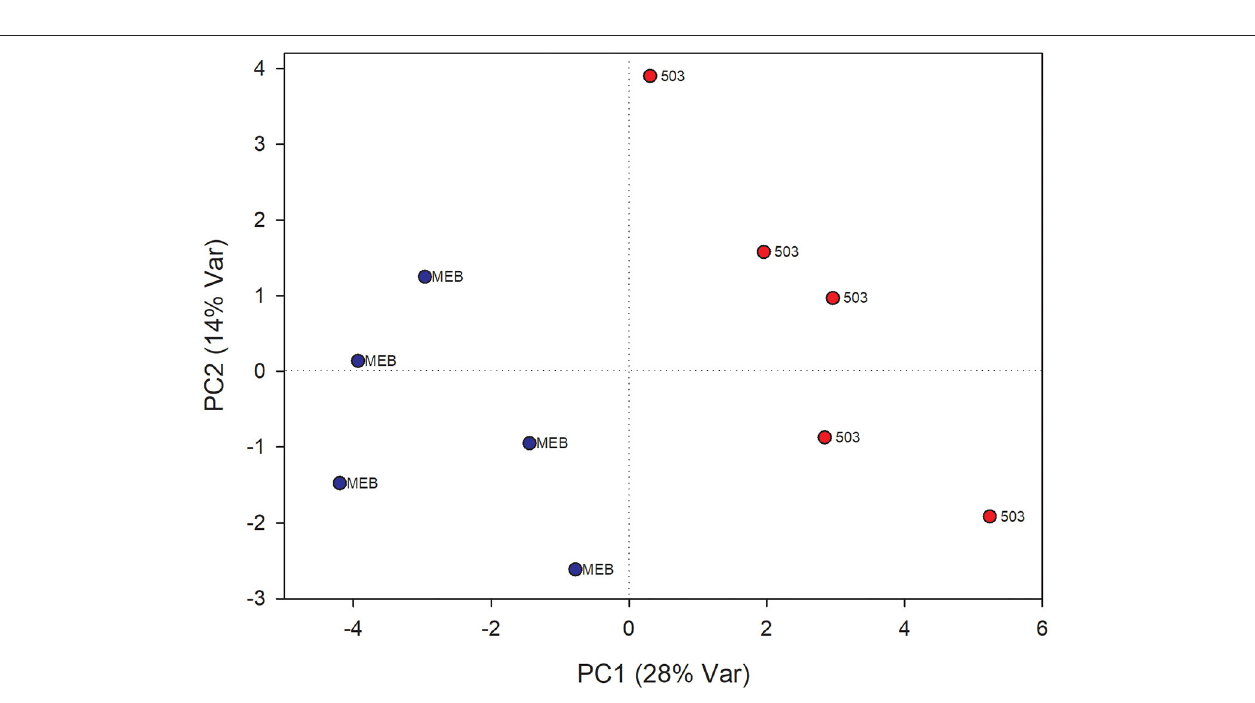
FIGURE 7 | PLS-DA score plot of NMR metabolomics data of chicory roots extracts of MEB (control) and M. polyspora (503) groups. Blue dots indicate MEB (control) group and red dots M. polyspora